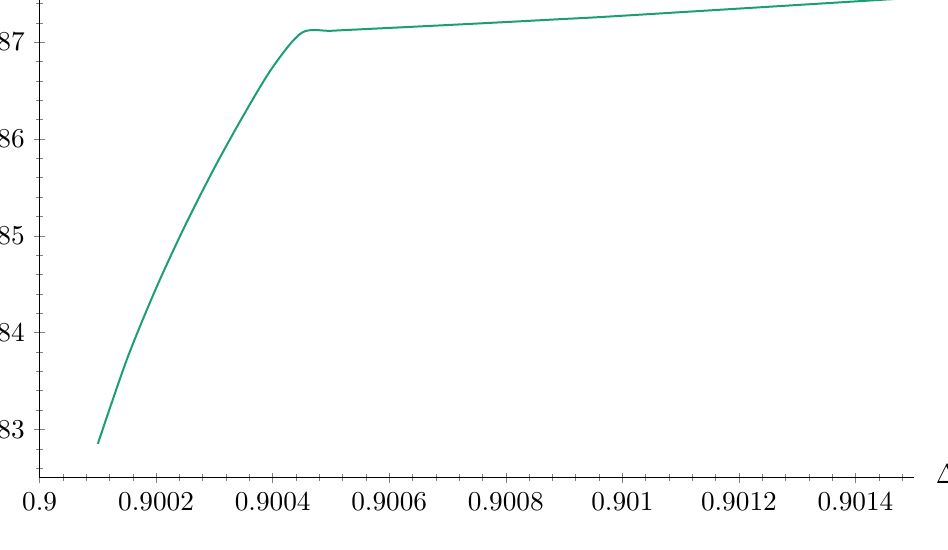
scalar operator in the (cid:30) i (cid:2) (cid:30) j OPE as (cid:3)